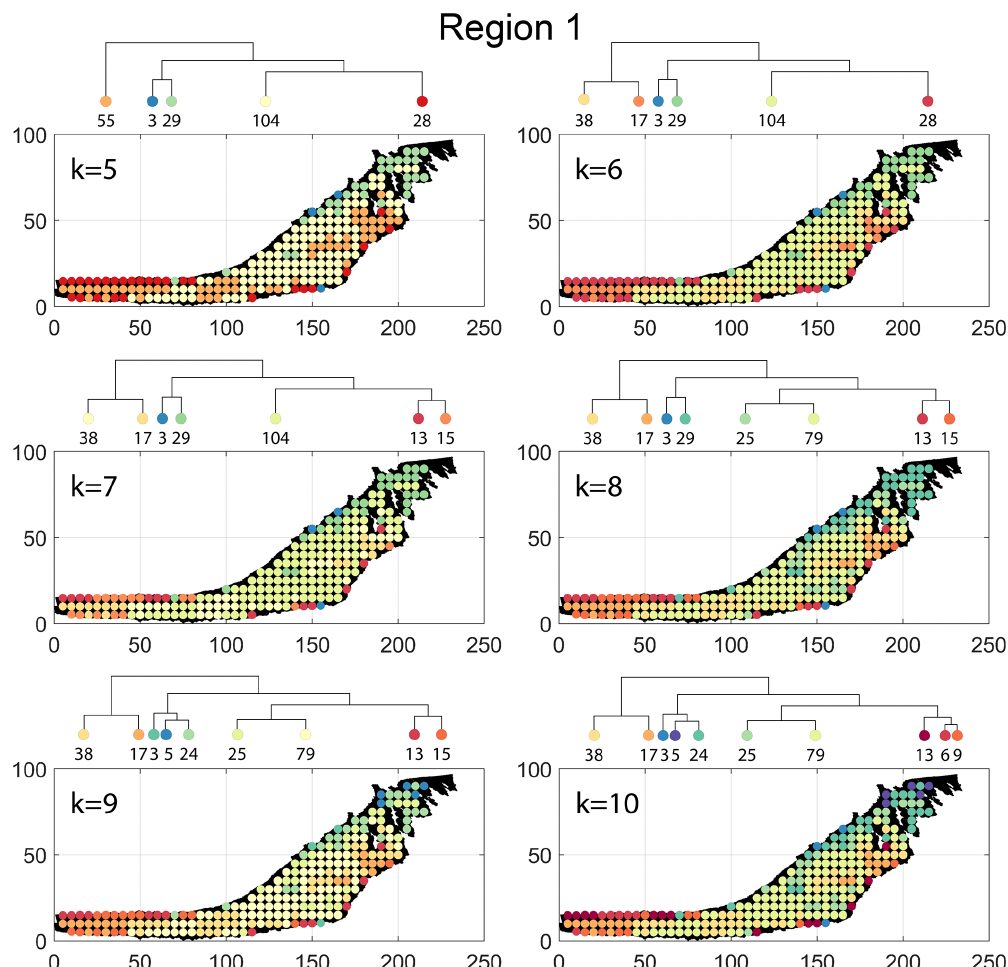
Figure B4. Variation in cluster boundaries for “ k ” clusters in Region 1 using portrait